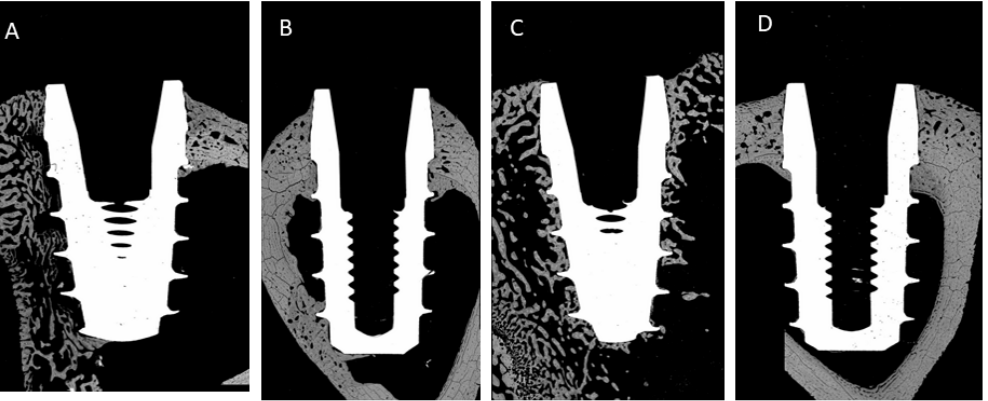
Figure 8. Histologies of the different bone-level dental implants inserted at bone level (h = 0 mm). ( A ) 3 weeks implanted and bone thickness of 1.5 mm; ( B ) 6 weeks implanted and bone thickness of 1.5 mm; ( C ) 3 weeks implanted and bone thickness of 2.5 mm; ( D ) 6 weeks implanted and bone thickness of 2.5 mm.